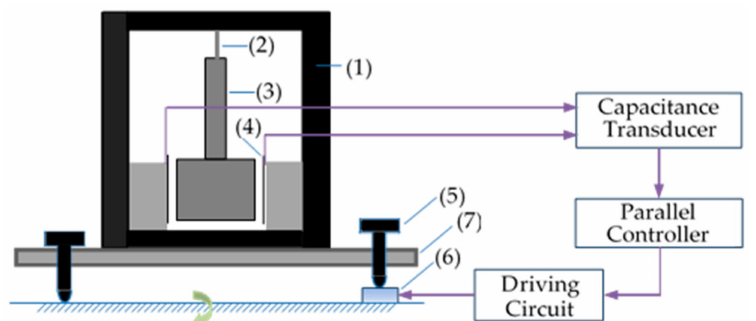
Figure 1. The schematic diagram of the tilt AVI. (1) is the supporting frame, (2) is the flat elastic spring, (3) is the pendulum body, (4) is the capacitance plates, (5) is the adjustable supporting plot, (6) is the piezoelectric actuator, (7) is the plate of the tiltmeter’s base.